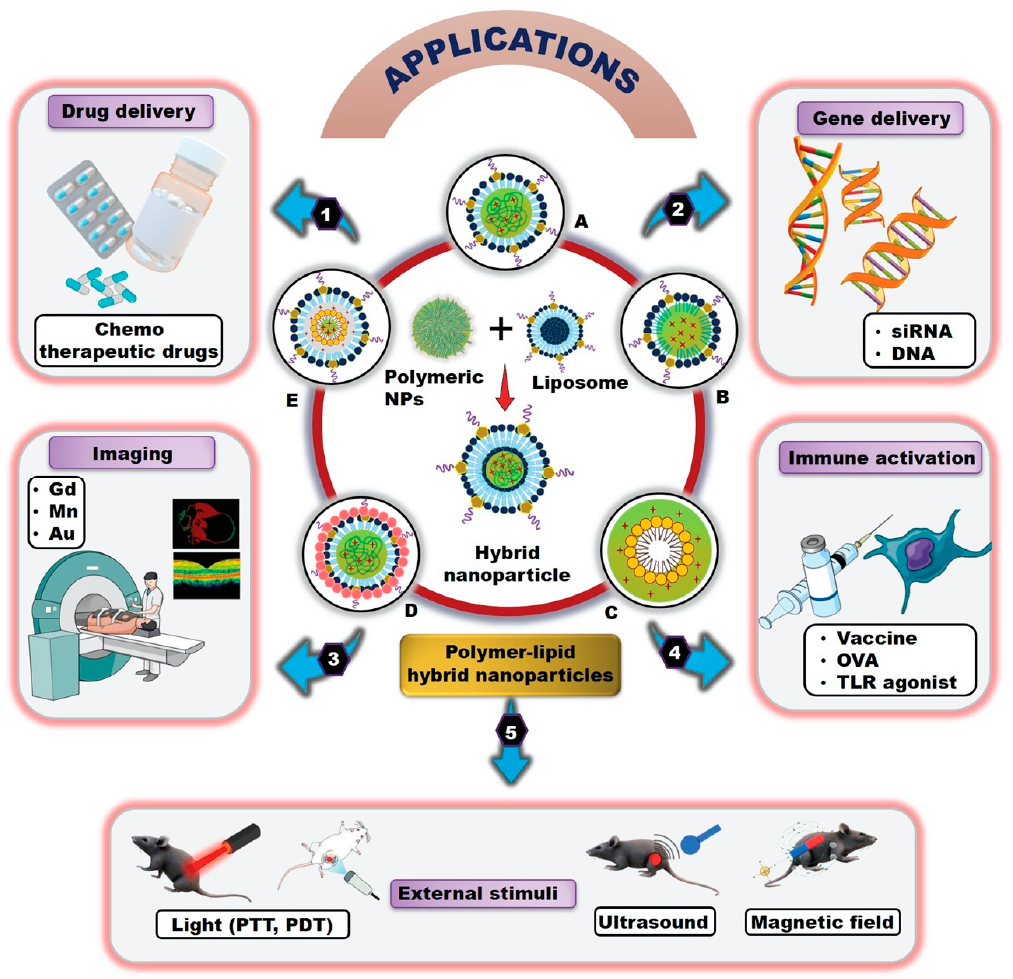
Figure 1. Overall schematic representation of polymer-lipid hybrid nanoparticles (PLHNPs) and their applications. The hybrid system is developed from polymeric nanoparticles and liposomes covered by di ff erent types of PLHNPs. ( A ) Polymer core lipid shell, ( B ) Polymer caged liposome, ( C ) Monolithic PLHNPs, ( D ) Erythrocyte membrane-coated PLHNPs), ( E ) Core shell-type hollow lipid-polymer-lipid hybrid nanoparticles. The di ff erent applications of PLHNPs are also shown. ( 1 ) Delivery of various chemotherapeutic drugs. ( 2 ) Delivery of genes (siRNA, DNA). ( 3 ) Delivery of vaccines, ovalbumin (OVA), and Toll-Like Receptor (TLR) agonist for immune activation. ( 4 ) Imaging applications based on gadolinium (Gd), manganese (Mn), and gold (Au). ( 5 ) Photothermal therapy (PTT), photodynamic therapy (PDT), ultrasound, and alternative magnetic field (AMF). Polymer ‐ lipid hybrid nanoparticles (PLHNPs) combine the advantages of both polymeric NPs